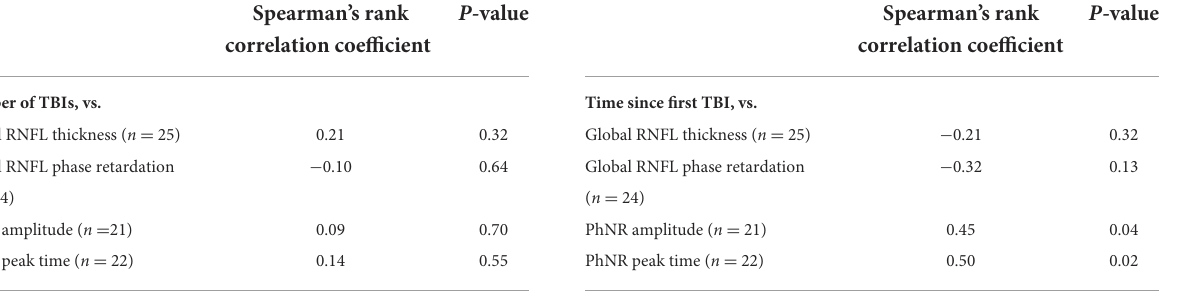
TABLE 6 Associations between number of traumatic brain injuries (TBIs) and retinal nerve fiber layer (RNFL) structural parameters and electroretinography functional parameters in case subjects.